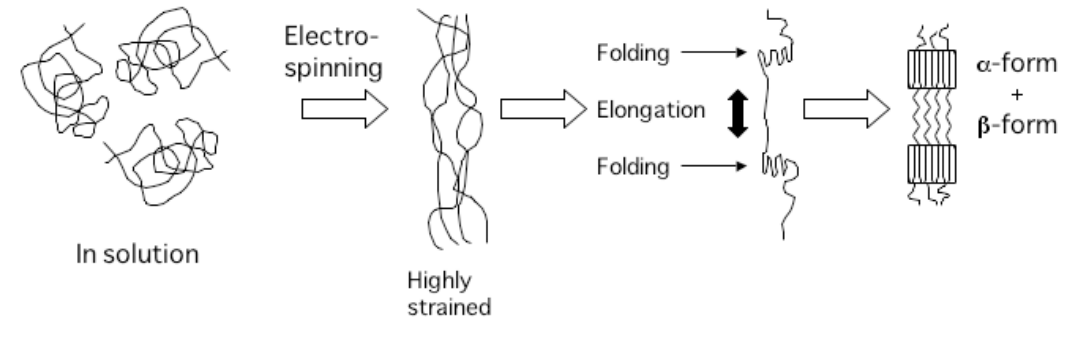
Figure 4. Schematic representation of the formation mechanism of β -form structure in P(3HB) nanofiber